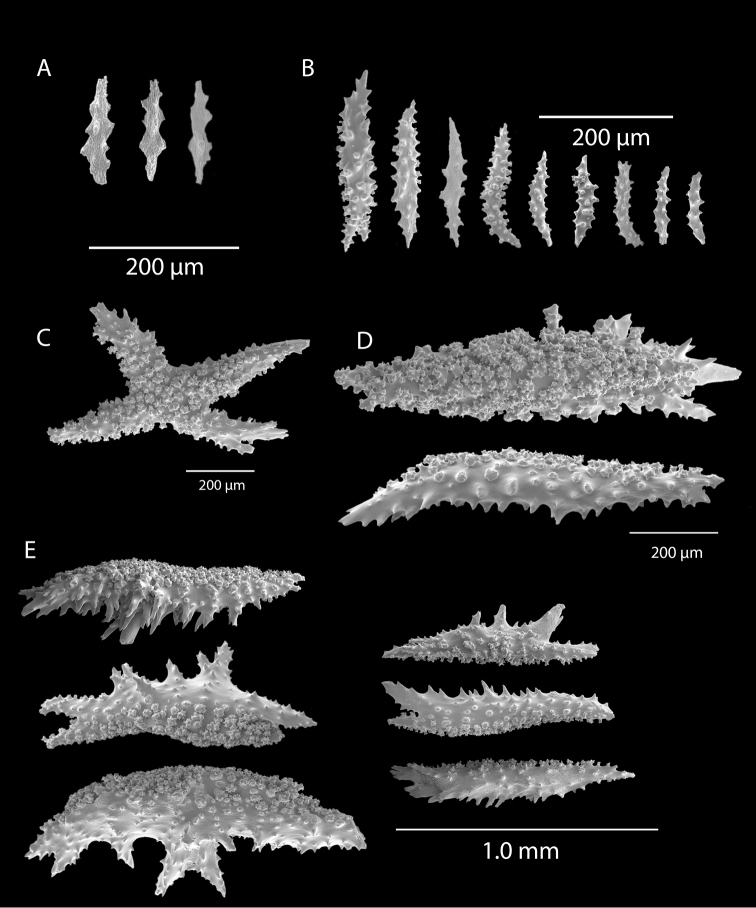
Muriceafruticosa, SBMNH 265945, SEM image. A Possible anthocodial sclerites B Spindles from the axial sheath C An unusual quadriradiate spindle from coenenchyme D Calycular/coenenchymal unilateral spinous spindles E Prominent calycular/coenenchymal tardigrade-type spindles.